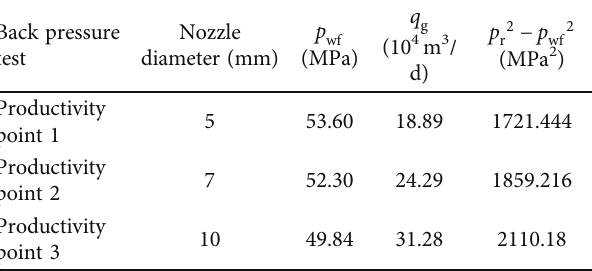
Table 4: Calculation parameters and results of empirical